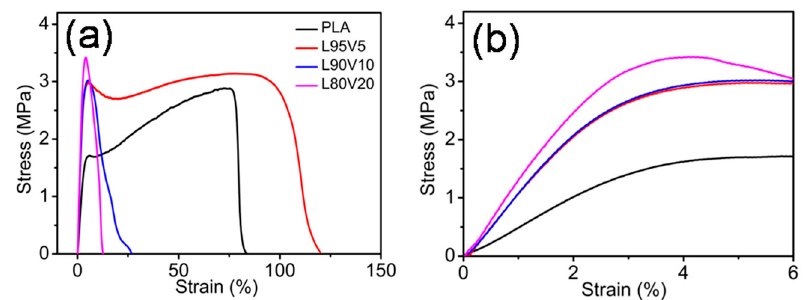
Figure 5. ( a ) Stress–strain curves of electrospun fiber PLA membranes; ( b ) magnified low-strain regions of the stress–strain curves.